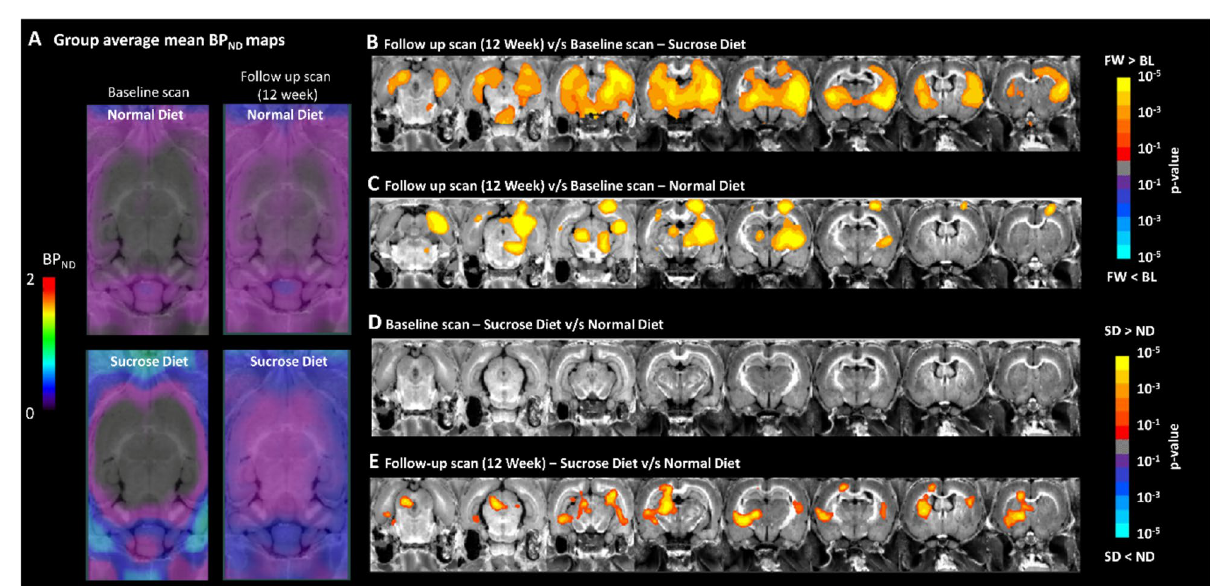
Figure 3. Voxel-wise analysis of effects of binge sucrose diet on the binding potential (BP ND ) of the TSPO PET tracer [ 18 F]DPA714. ( A ) Mean parametric maps of BP ND at baseline and follow-up scans for the rats in the sucrose or normal diet or sucrose diet groups. Each map is the mean of determinations in groups of nine rats. The voxel-based analysis showed increased BP ND of the PET tracer [ 18 F]DPA714 in the follow up scan as compared to baseline in ( B ) sucrose diet and ( C ) normal diet groups, showing greater increases in the sucrose diet group. When comparing between sucrose diet and normal diet groups, the data showed ( D ) no differences at the baseline scans between the animals, while ( E ) increased TSPO expression as reflected by the greater [ 18 F] DPA714 BP ND in the sucrose diet group compared to the normal diet group at the follow up scans. The results shown here are corrected for multiple comparisons using the family-wise error correction method (FEW; p < 0.05). FL follow up, BL baseline, SD sucrose diet, ND normal